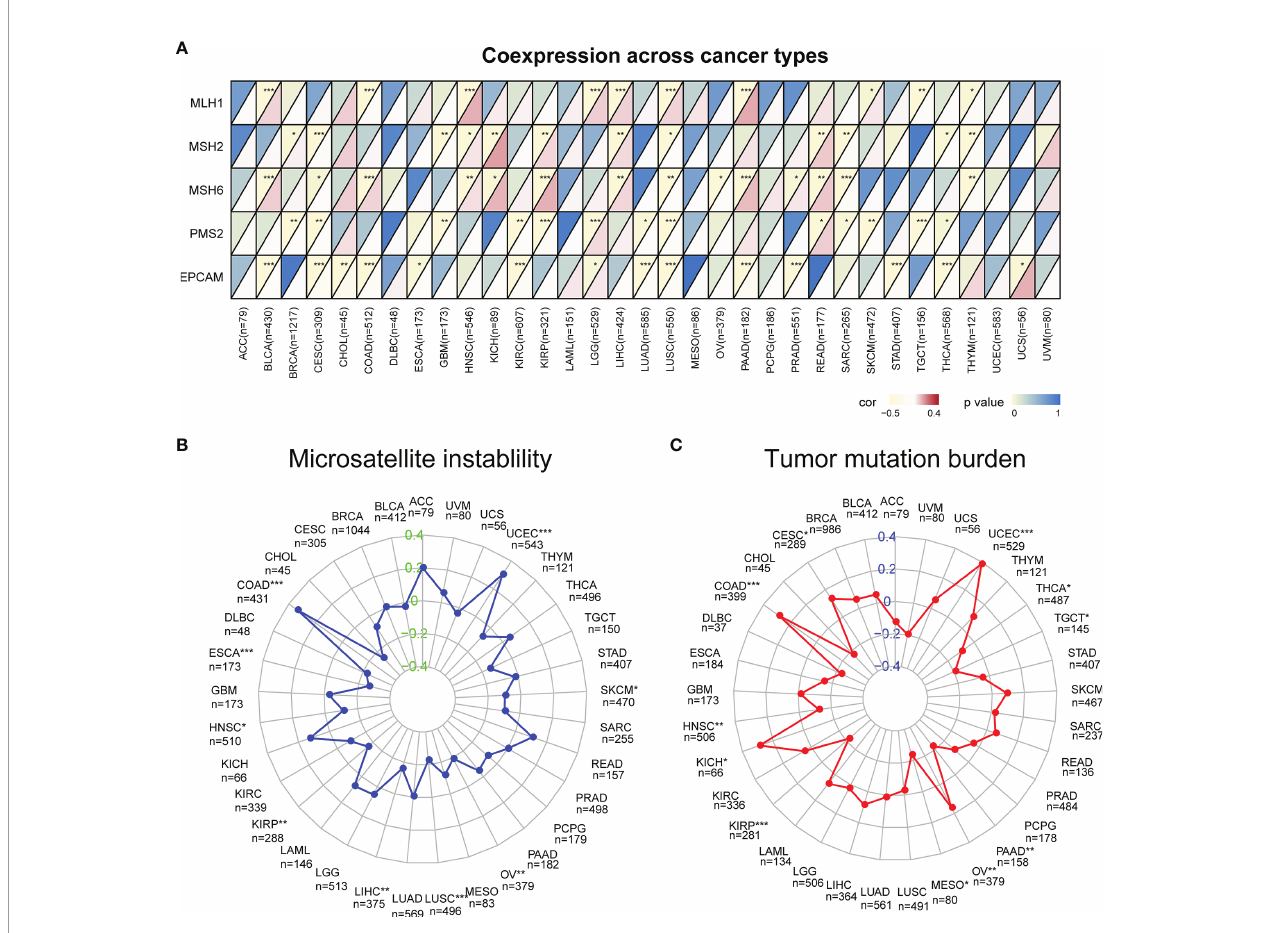
FIGURE 6 | Correlation between CXCL13 expression and the mutation levels of (A) Mismatch Repair Genes (MMRs), (B) Microsatellite Instability (MSI), (C) Tumor Mutation Burden (TMB). *P < 0.05, **P < 0.01; ***P <